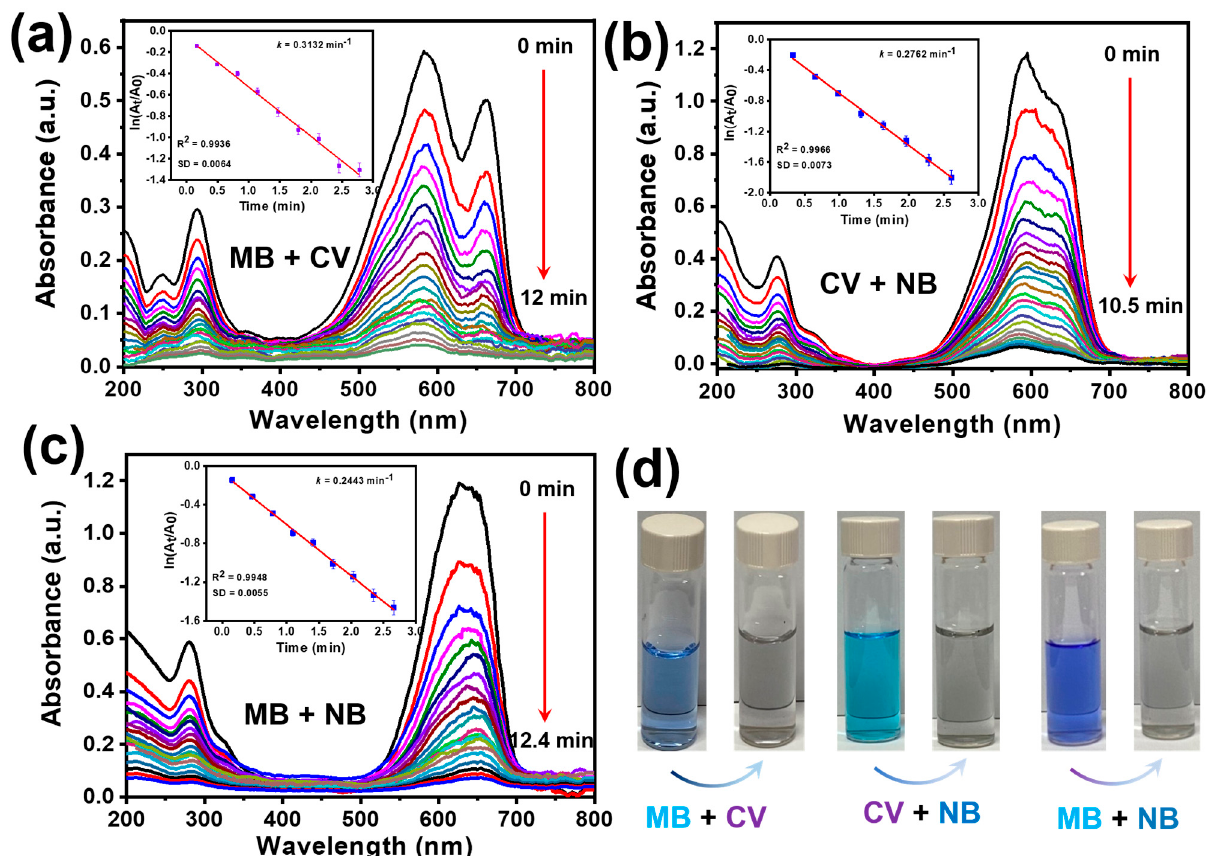
Figure 7. UV–vis spectra representing simultaneous reduction in ( a ) MB + CV, ( b ) NB + CV, ( c ) NB + MB dyes in the presence of the NBP-PC-Zn catalyst, ( d ) the photographs of colour changes after the dye reductions. Reaction conditions: solution = dyes (20 mL, 0.1 mM), NaBH 4 = 0.5 mL (0.45 mM), catalyst = 0.6 mg, 25 °C.